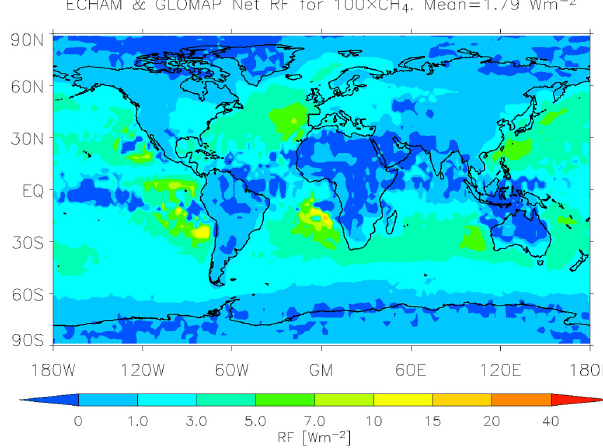
Fig. 6. Predicted cloud-albedo aerosol radiative forcing (in Wm − 2 ) associated with a CH 4 concentration increased by a factor of 100, using GLOMAP and E-S.